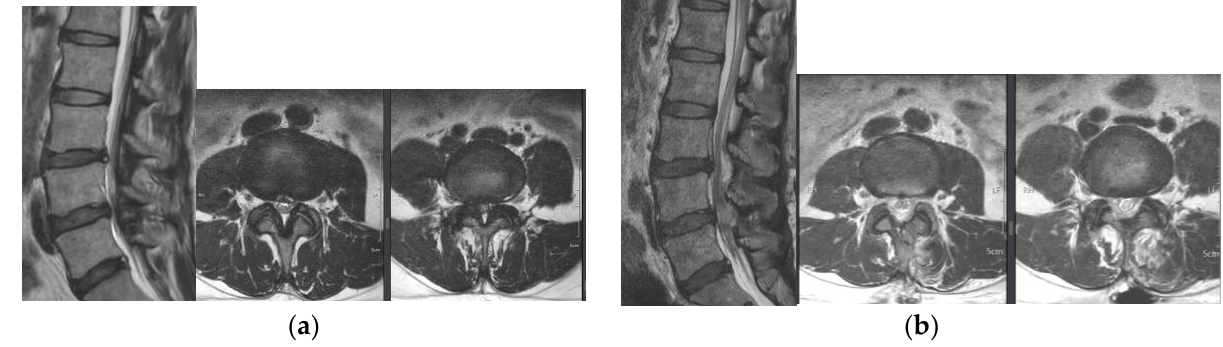
Figure 1. Pre-operative ( a ) and post-operative ( b ) MR images of a 76-year-old female patient with L3 – 4 – 5 spinal stenosis who underwent BESS surgery.